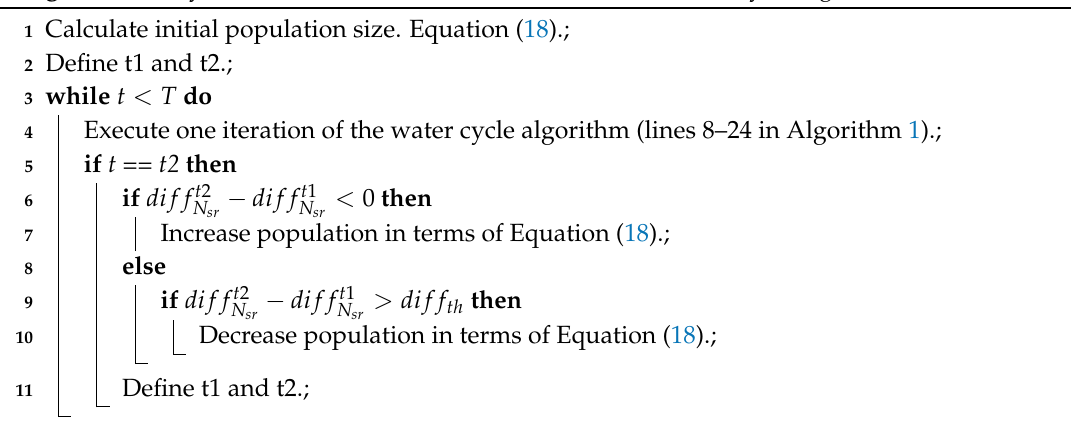
Algorithm 2: Hybridization of autonomous search and the water cycle